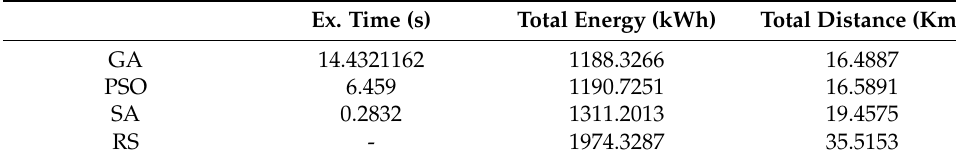
Table 7. Execution results.